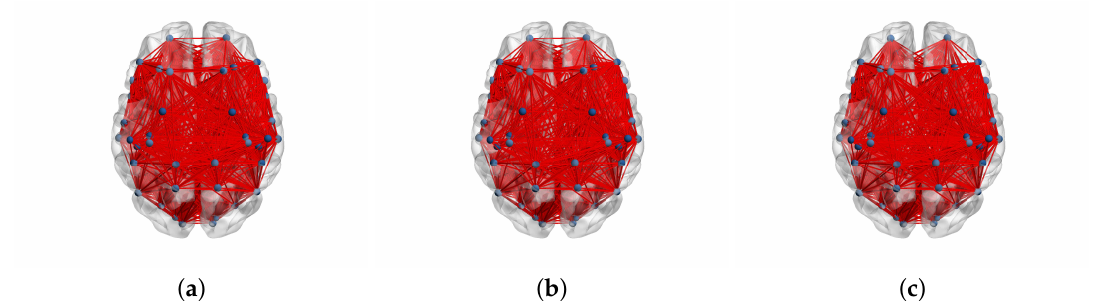
Figure 4. Connections between ROIs for 18 electrodes of: ( a ) CNT, ( b ) MCI and ( c ) AD.